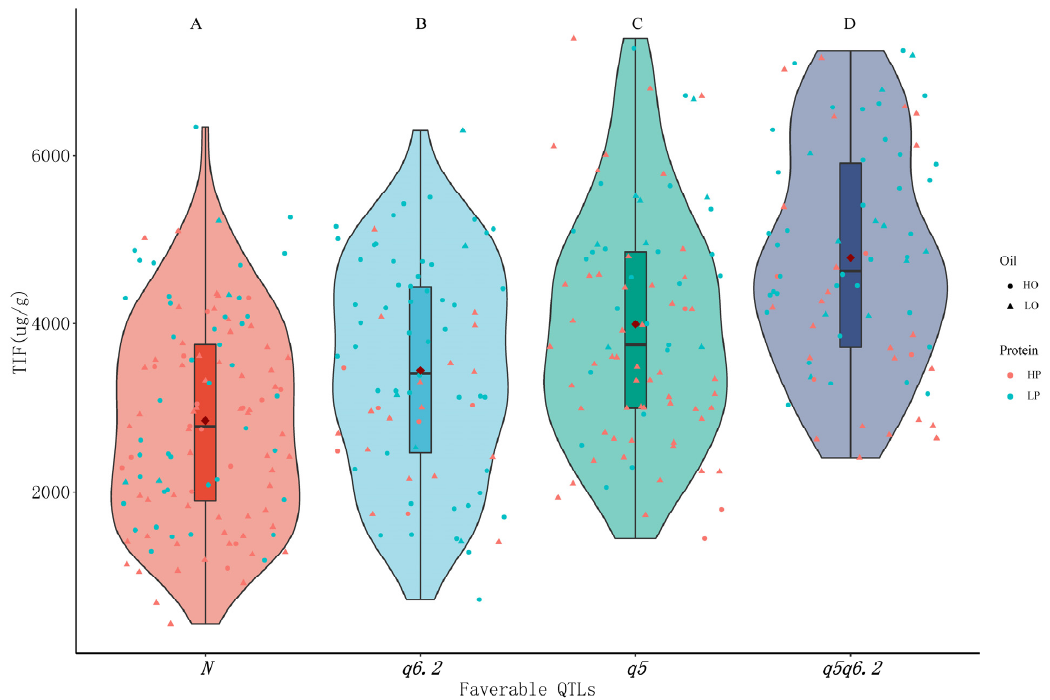
Figure 6. Effect of combining favorable loci from qISO5 and qISO6.2 on total isoflavone (TIF), protein and oil contents in the RIL population, produced as described in the Materials and Methods section. Letters (A, B, C, D) indicate the significance of differences as determined by Fisher’s LSD method at a 0.01 significance level. Different shapes represent different levels of oil content, and different colors represent different levels of protein content. N represents lines with no tested favorable loci, while q5 and q6.2 represent lines with the favorable loci qISO5 and qISO6.2 , respectively. HP and HO denote respective protein and oil contents in excess of the mean values across the RIL population. LP and LO denote respective protein and oil contents below the mean values across the RIL